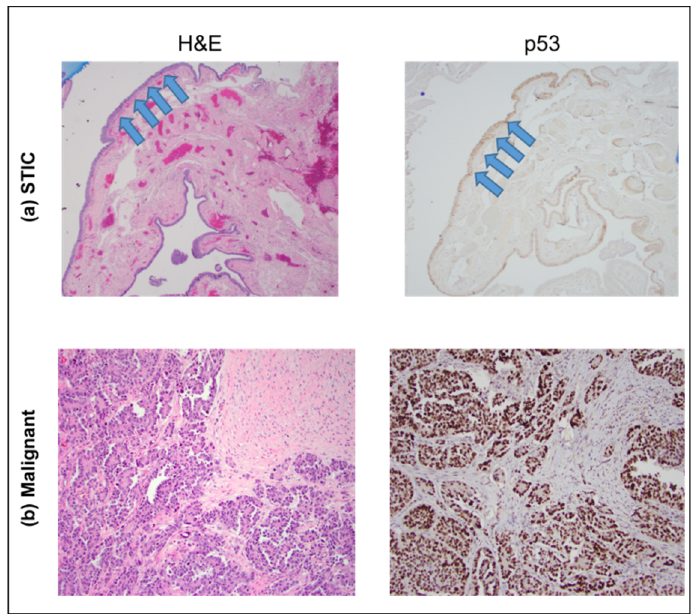
Figure 2. H&E ( left ) and p53 ( right ) staining of sections showing a STIC lesion (top, ( a ) images) and HGSOC (bottom, ( b ) images), respectively. The STIC lesion is confined to the fallopian tube epithelial surface (arrows), whereas the HGSOC forms a destructive, expansile lesion within the stroma of the involved tissue. The images were acquired at 40×.